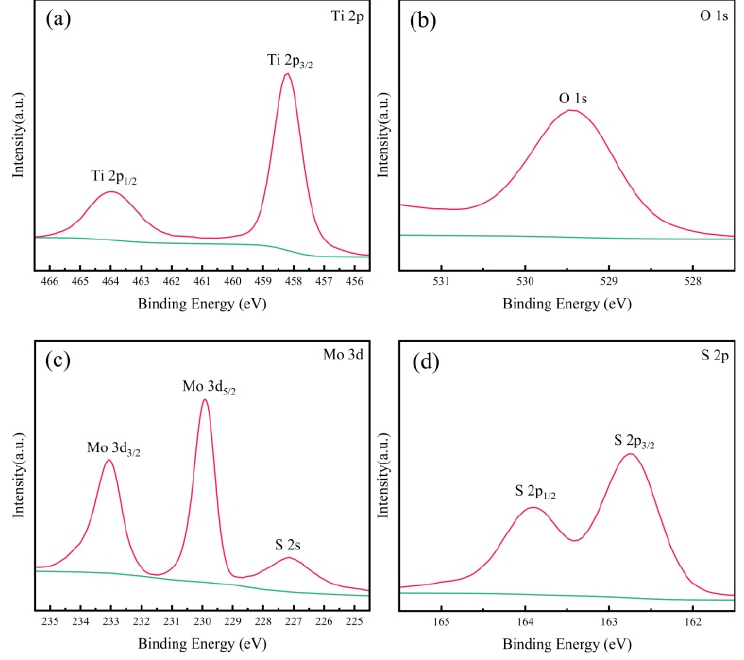
Figure 4. XPS spectra of TiO 2 /MoS 2 : ( a ) Ti 2p, ( b ) O 1s, ( c ) Mo 3d, ( d ) S 2p.